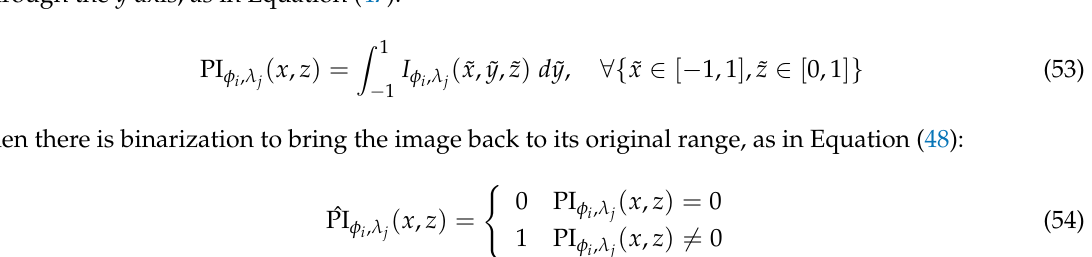
Figure 2. Generation of the projected pseudo-volume: ( a ) Original 3D object, I ( ρ , θ , z ) ; ( b ) Object rotated at the θ i angle around the z axis and converted to Cartesian coordinates, I θ ( c ) Binarized projection through the y axis, ˆPI θ the